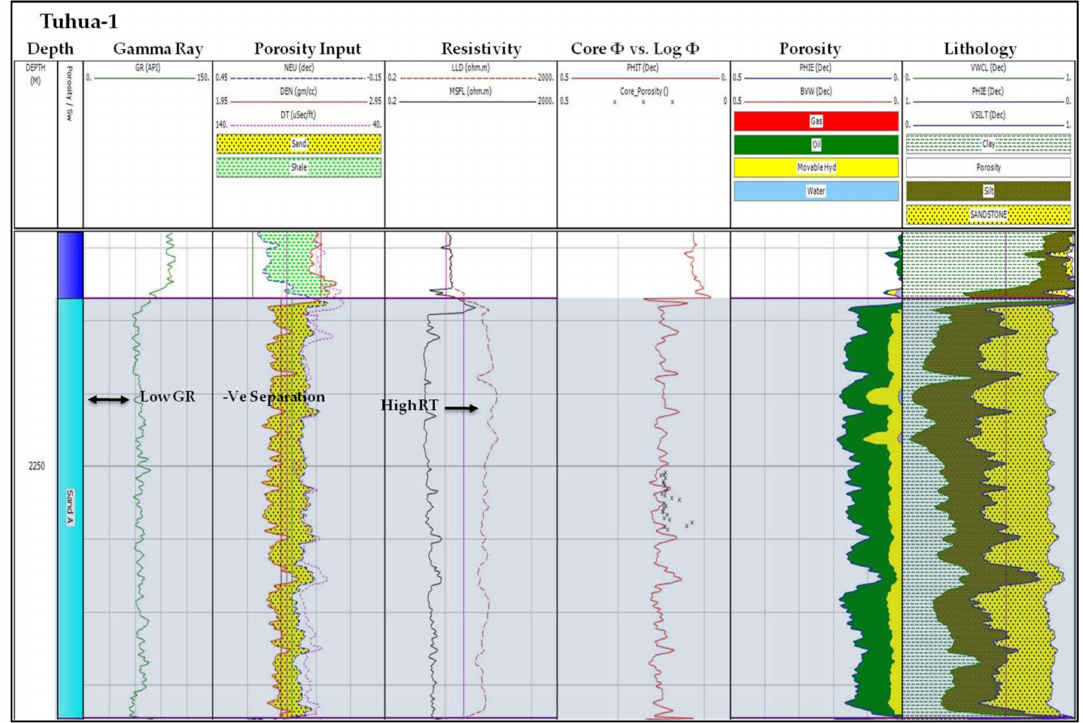
Figure 11. Litho-saturation plot of Tuhua-1. GR: Gamma Ray; -Ve Separation: Negative Separation; RT: High